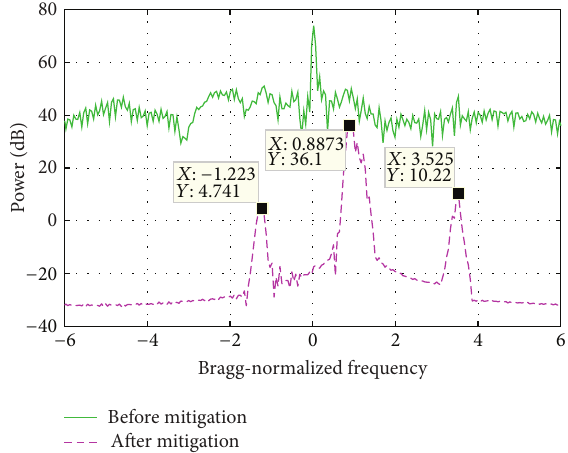
Figure 11: Echo power spectrum density before and after WTC mitigation.